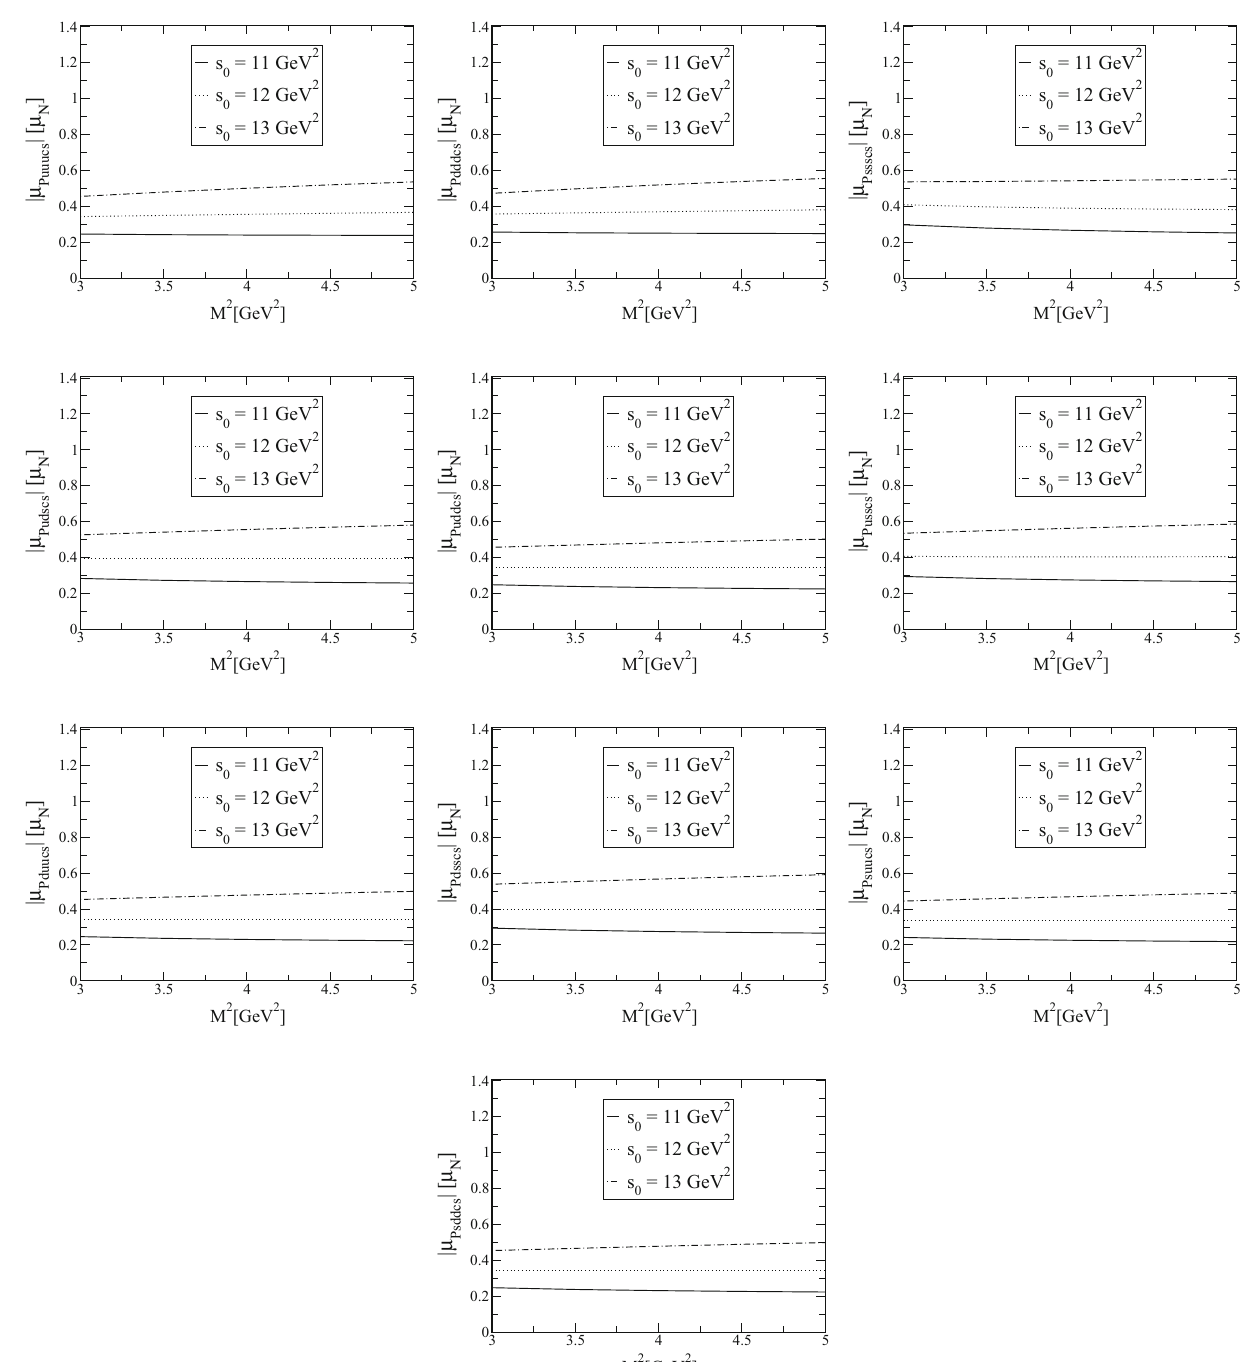
Fig. 1 The magnetic dipole moments for P c ¯ s pentaquarks versus M 2 at various fixed values of the s 0